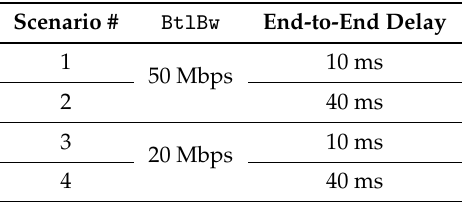
Table 2. Interaction experimental